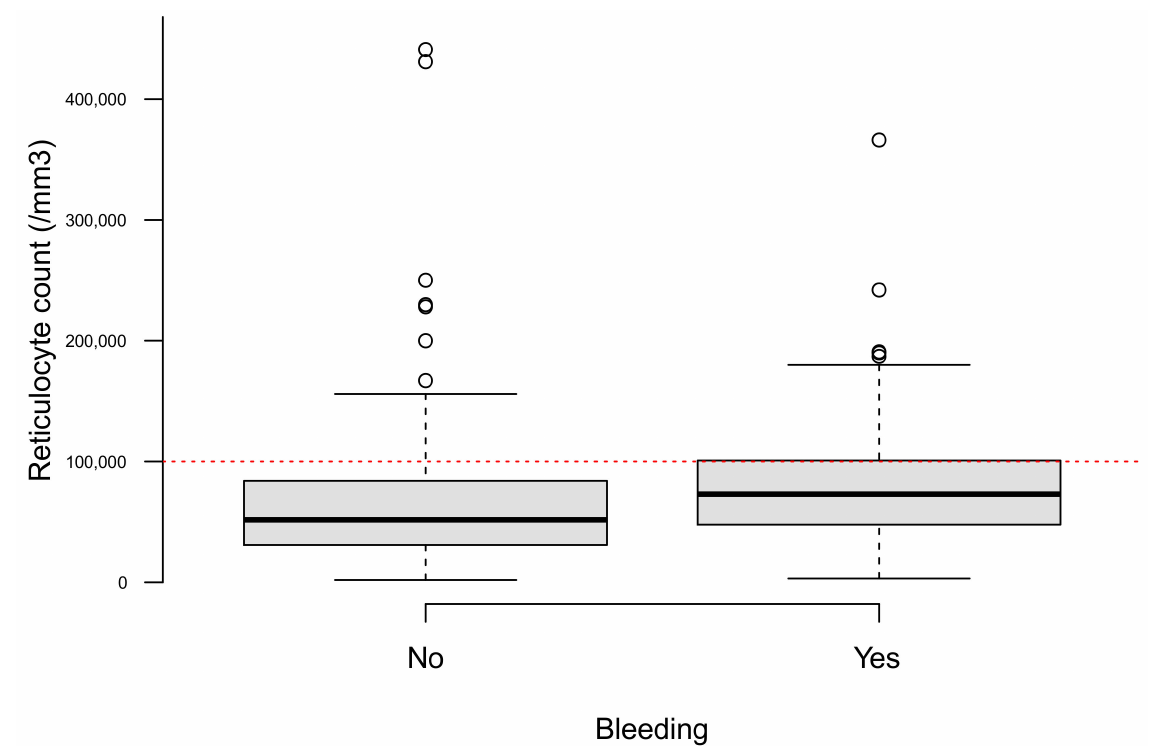
Figure 4. Boxplots showing the reticulocyte count depending on whether a bleeding was observed in the ED ( N =